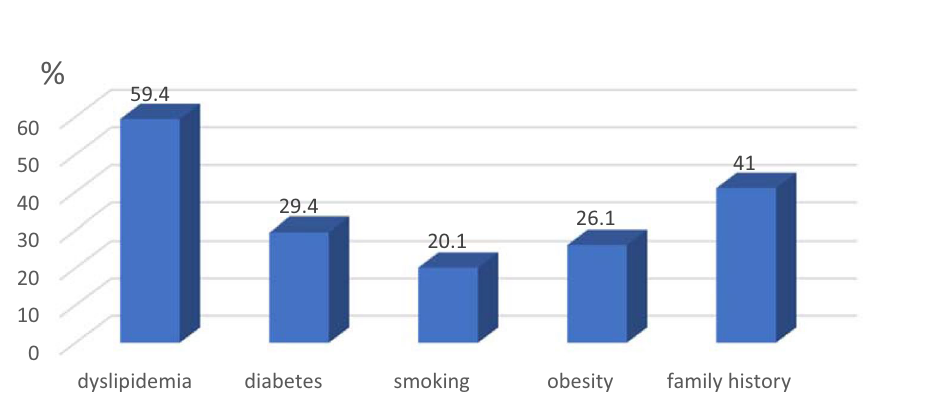
Figure 1. Valid percent of the risk factors in the group of